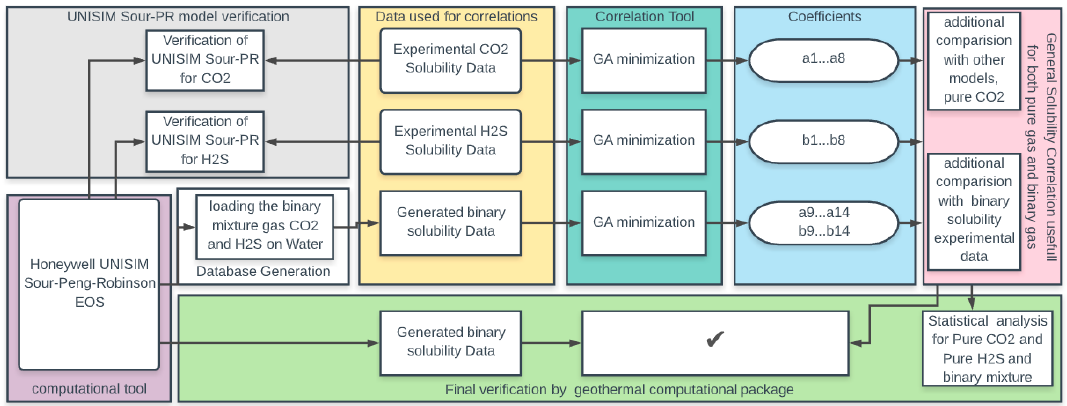
Figure 4. Process diagram of the research.